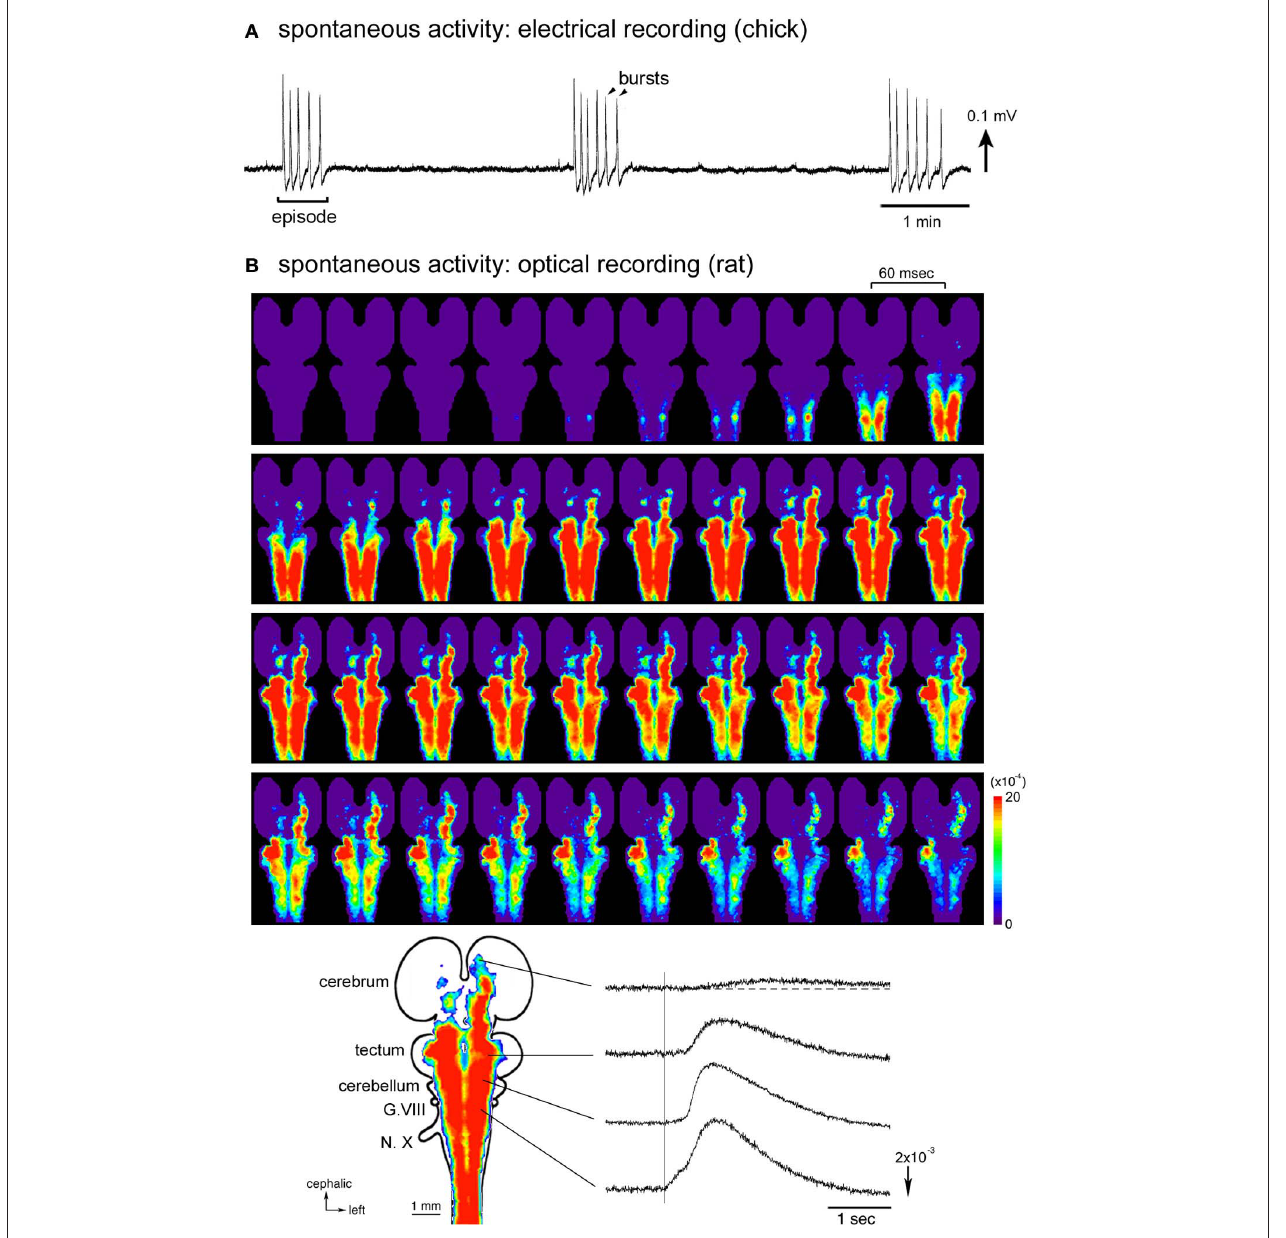
FIGURE 1 | (A) Electrical recording of the spontaneous activity in the chick embryo. The signal was recorded from a brainstem-whole spinal cord preparation dissected from a stage 27 (E5.5) embryo with a glass micro-suction electrode applied to the root of the vagus nerve. (B) Optical imaging of the spontaneous activity in the rat embryo. The whole brain-spinal cord preparation dissected from an E16 embryo was stained with a voltage-sensitive dye NK2761, and optical